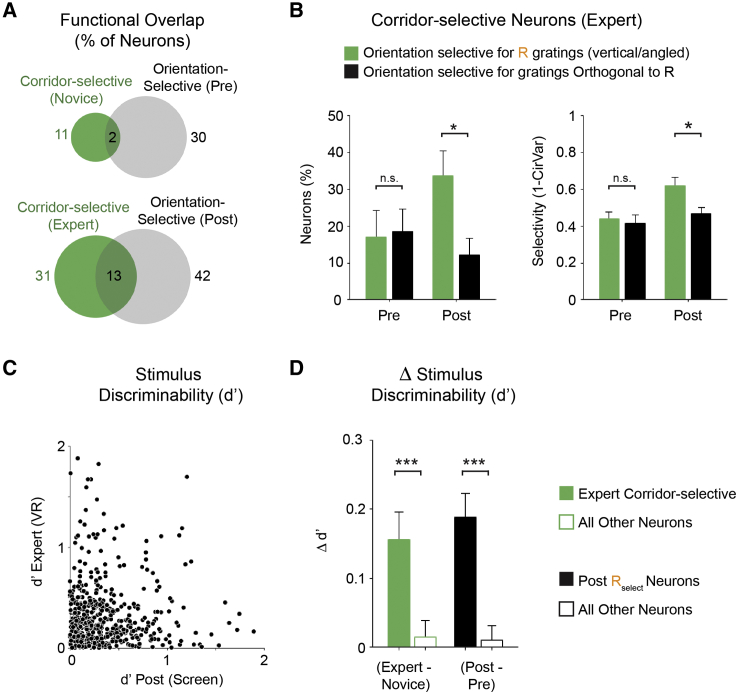
Different Subpopulations of Grating-Selective Neurons across Viewing Contexts(A) Percentage of corridor-selective neurons in the virtual environment (green; for novice [top] or expert [bottom]) and orientation-selective neurons during single-screen viewing (gray; selective for any orientation [either 0°, 45°, 90°, or 135°] on pre [top] or post [bottom] testing day); percentage of overlapping indicated in center.(B) Among the population of corridor-selective neurons on expert day: the proportion that is orientation selective for the R gratings (green; either vertical or angled) or for the gratings orthogonal to the R gratings (black) is shown on the left and, on the right, the magnitude of their selectivity for both pre and post testing days. ∗p < 0.05; n = 5 mice; Mann-Whitney U test.(C) Stimulus discriminability (d’) between vertical and angled gratings in the VR on expert day and between the vertical and angled gratings under single-screen viewing conditions on post testing day for each neuron (n = 510 neurons from 5 mice).(D) Change in d’ from novice to expert day between the two R gratings in the virtual environment (vertical and angled) for the corridor-selective population (green; n = 158) versus all other neurons (n = 352) and change in d’ from the pre to post testing day during single-screen viewing for the population of neurons that are orientation selective for the R grating (Rselect; black; n = 166) versus all other neurons (n = 344). ∗∗∗p < 0.001; Mann-Whitney U test. All panels, error bars: SEM.